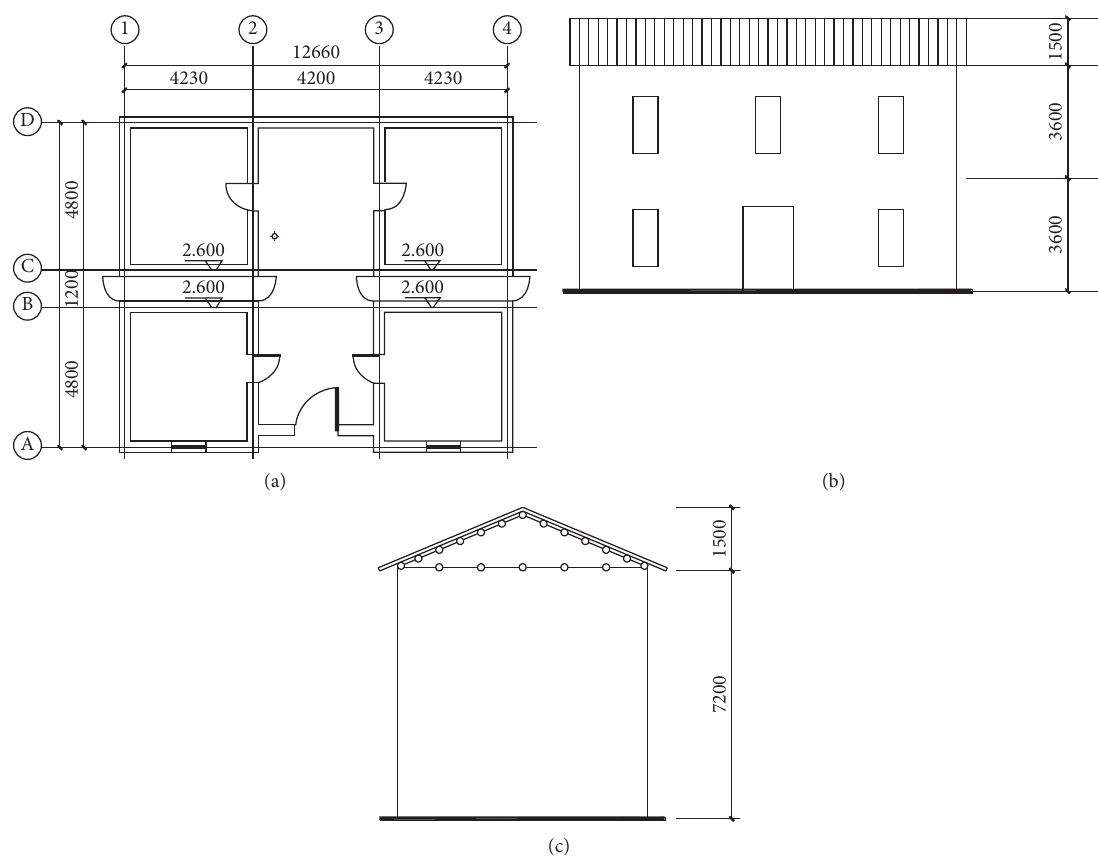
Figure 5: Architectural diagram of brick-wood structural house. (a) Layout plan of an engineering project. (b) Front elevation layout. (c) Model side elevation layout.